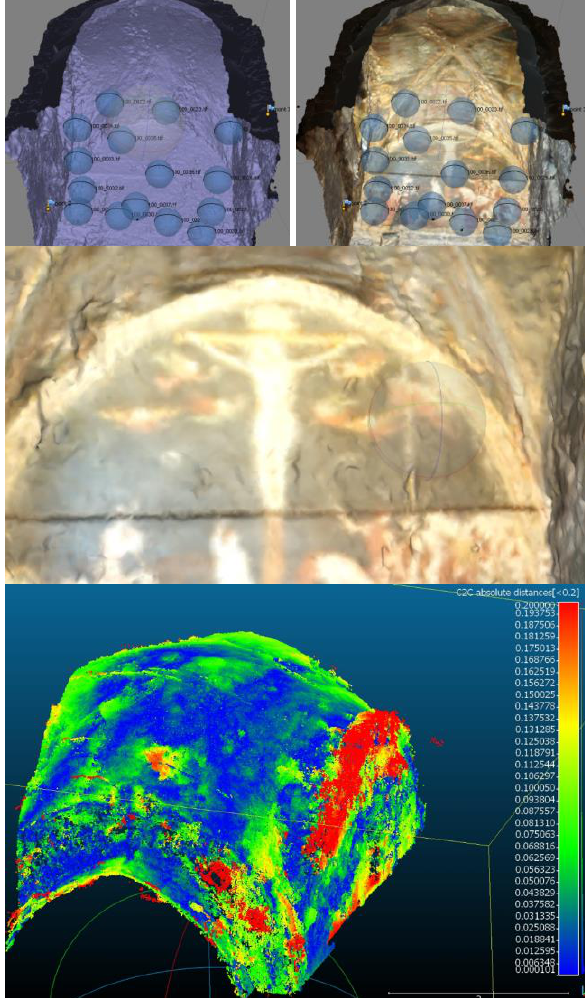
Figure 7. The discrepancy between laser scanning and image- based reconstruction with the equirectangular projections generated with the mobile phone app. The reconstruction is quite noisy and the overall error is about 80